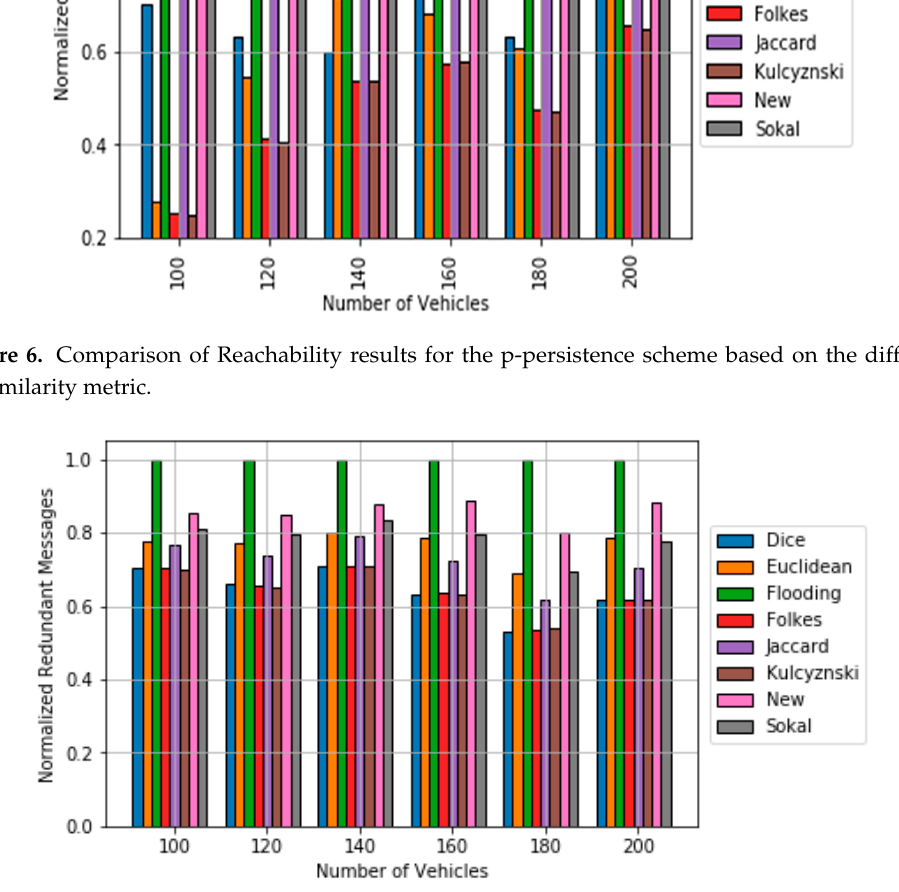
Figure 7. Comparison of redundancy results for the p-persistence scheme based on the different dissimilarity metric.